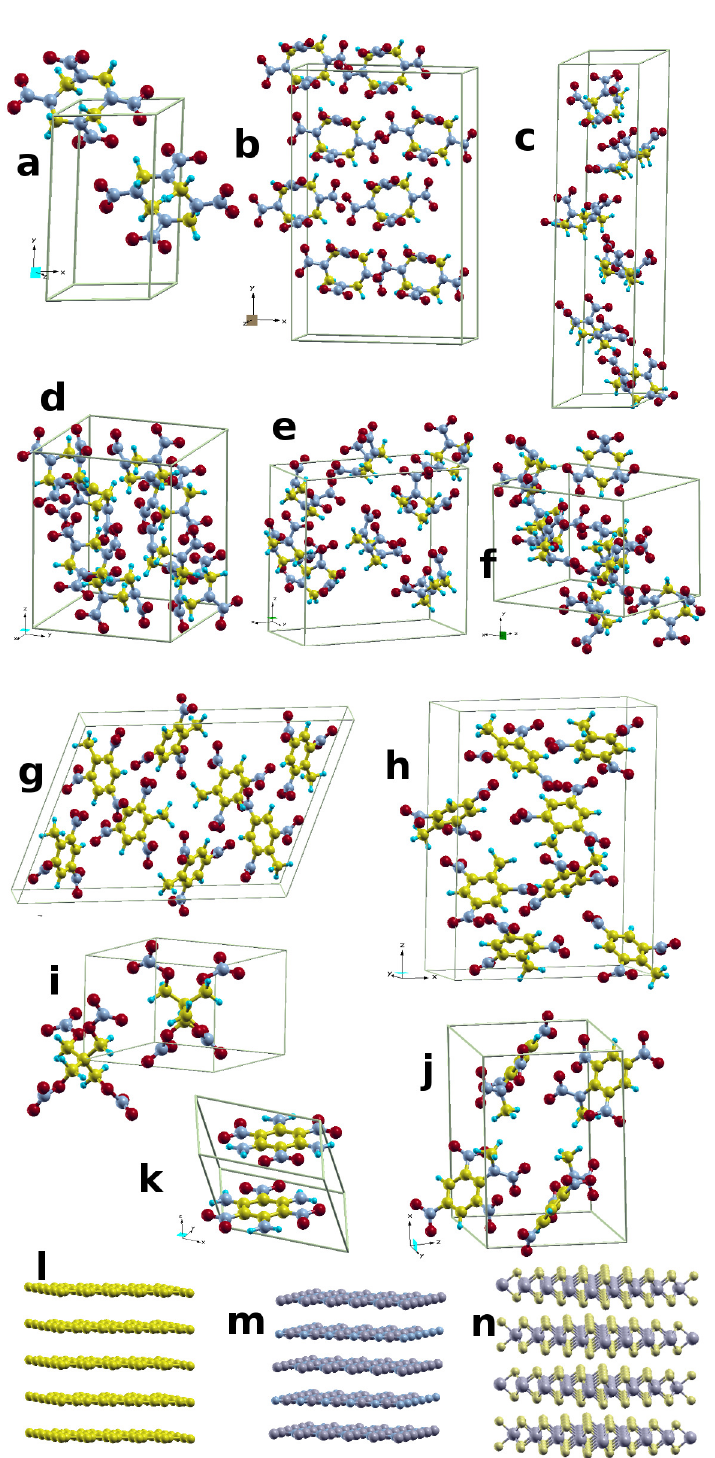
Figure 1. Semihard materials. The primitive unit cell of ( a ) β -HMX, ( b ) α -HMX, ( c ) δ -HMX, ( d ) α -RDX, ( e ) β -RDX, ( f ) γ -RDX, ( g ) α -TNT, ( h ) β -TNT, ( i ) PETN, ( j ) Tetryl, and ( k ) TATB. The layer materials are ( l ) Graphite, ( m ) h -BN, and ( n ) MoS 2